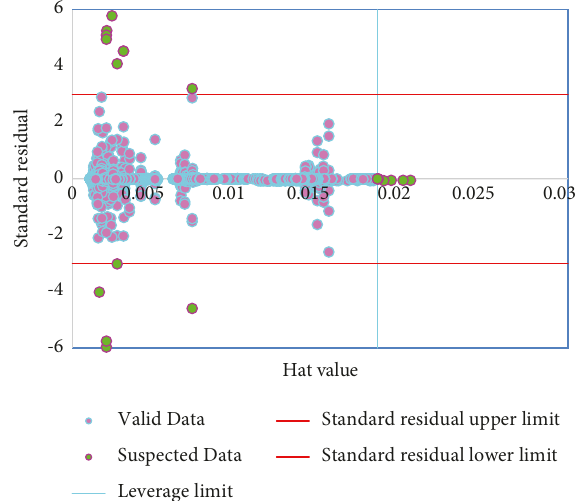
Figure 5: Detection of the suspicious dataset for the LSSVM model.